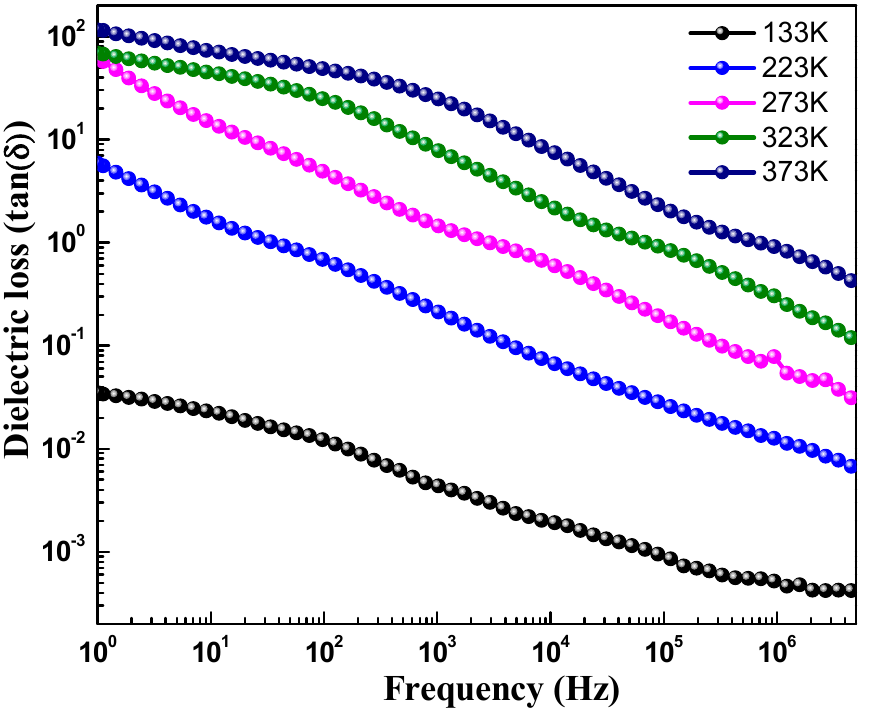
Figure 6. Loss tangent (tan δ ) versus frequency curve of CeFe 2 O 4 nanostructures at different temperatures.